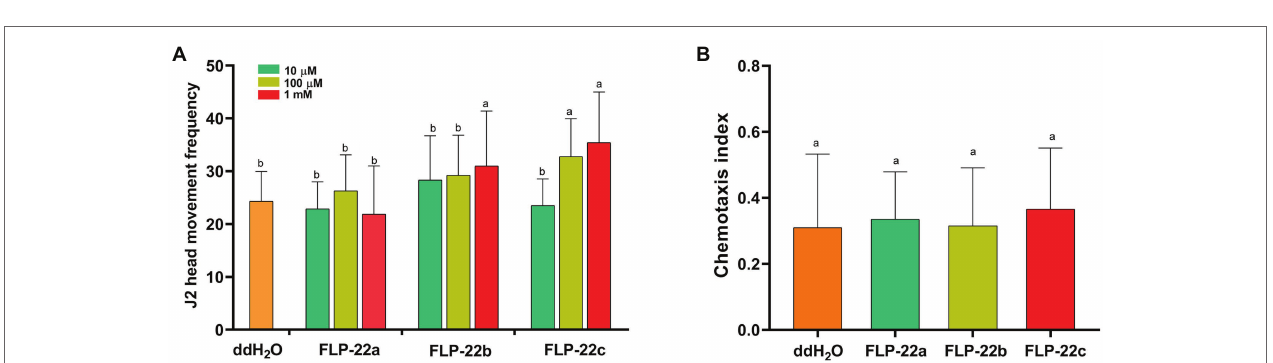
FIGURE 6 | Effect of three mature Hg-FLP-22 peptides on the in vitro behavior of H. glycines J2s. (A) Effect of Hg-FLP-22 peptides on the frequency of J2 head movements per minute. Each value represented the mean head movement frequency ± SD from 60 individual nematodes. The same letters indicate no significant differences between the peptide treatments and ddH 2 O control ( p > 0.05, Dunnett’s test). (B) Effect of Hg-FLP-22 peptide treatments on chemotaxis indices of H. glycines J2s. Each bar represents the mean ± SD of the data from the two independent experiments. The same letters indicate no significant differences from ddH 2 O control ( p > 0.05, Dunnett’s